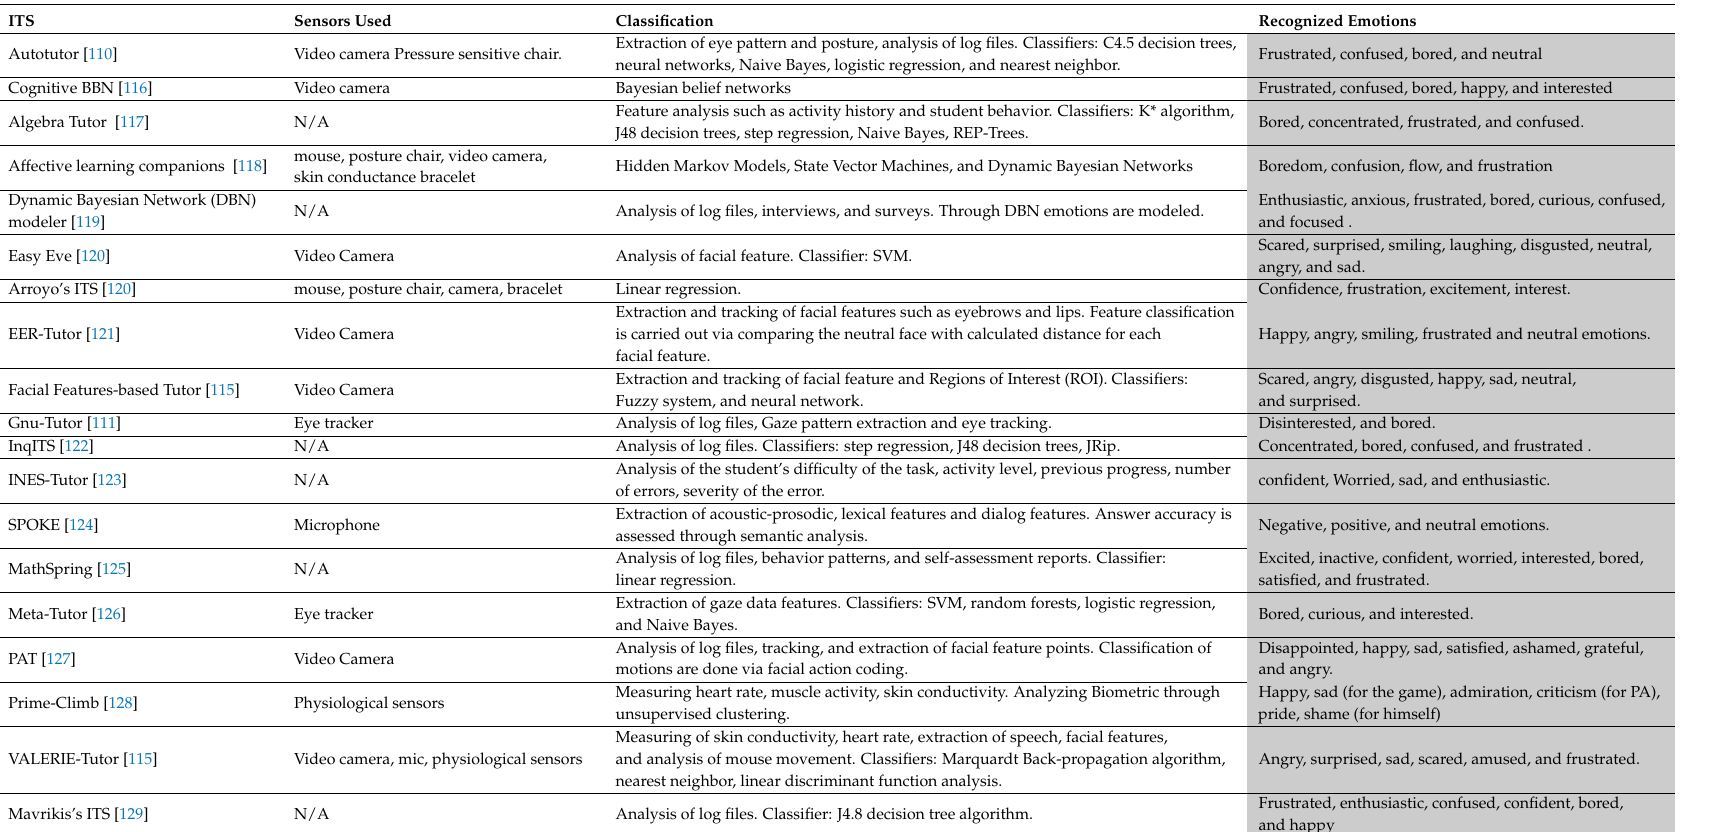
Table 2. Categories and methods of modern